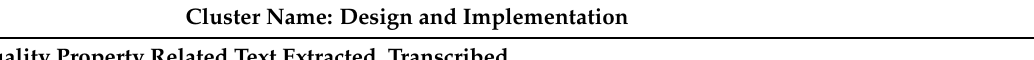
Table A5. Quality Property Cluster: Design and